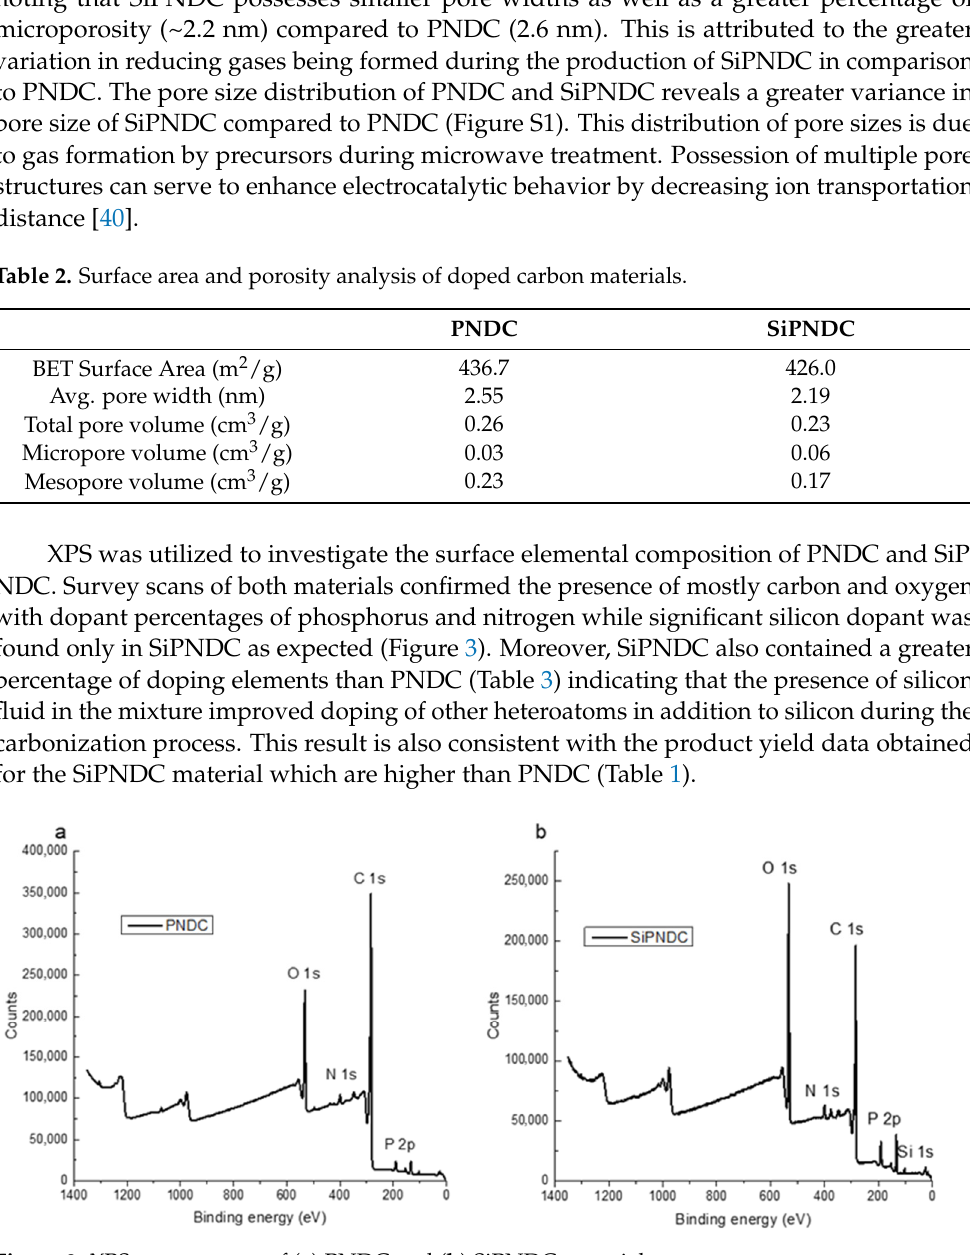
Figure 3. XPS survey scans of ( a ) PNDC and ( b ) SiPNDC materials. Table 3. Surface elemental composition of PNDC and SiPNDC materials from XPS .